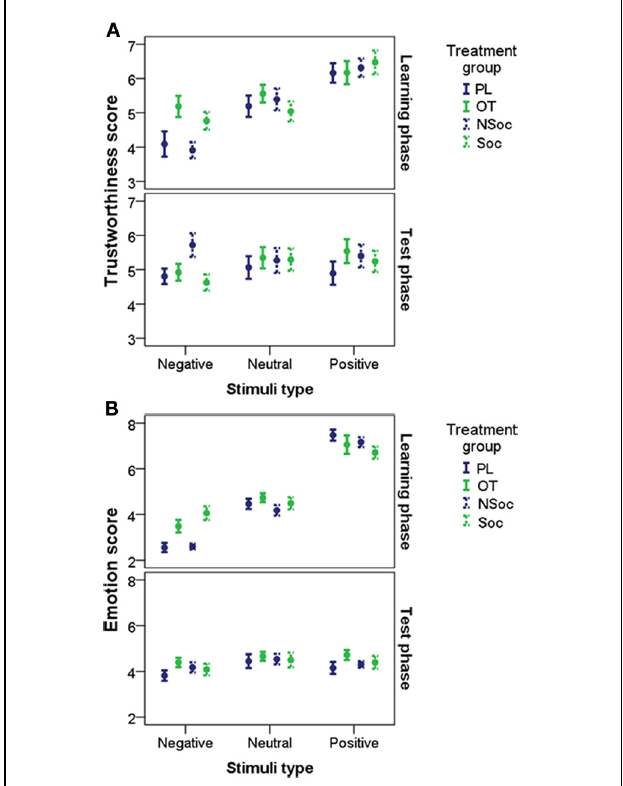
FIGURE 3 | Trustworthiness (A) and Emotion (B) scores (mean ± SE) in the OT/PL and Soc/NSoc groups for negative, neutral and positive faces in the learning and the test